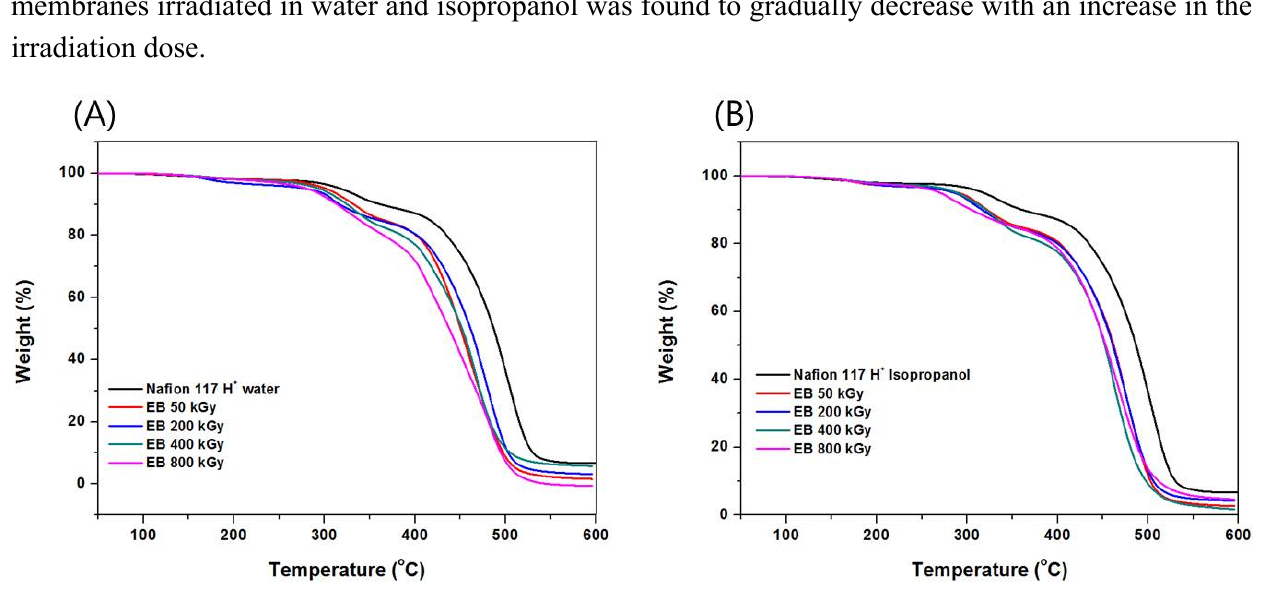
Figure 4. TG curves of EB-irradiated Nafion membranes in acid form under a N 2 atmosphere: ( A ) in water; ( B ) in isopropanol